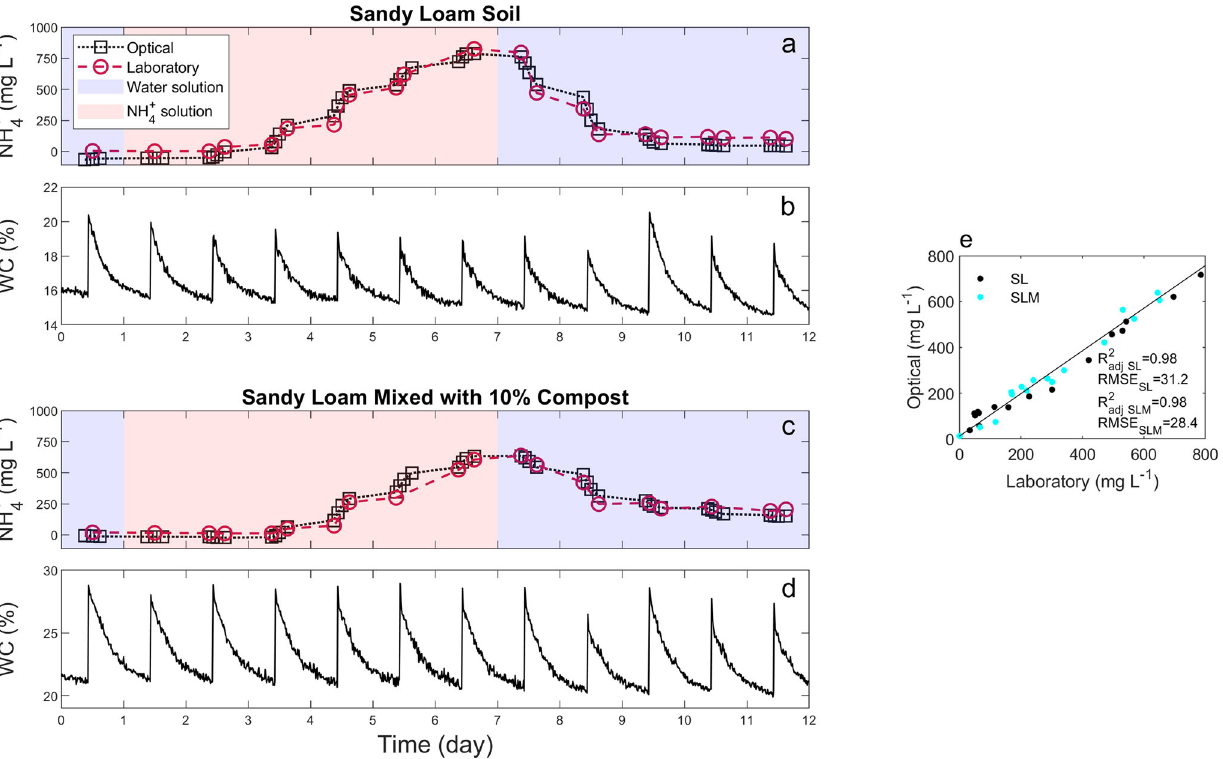
Fig. 4 Ammonium breakthrough curves in soil columns. a , c Breakthrough curves of ammonium in the sandy loam soil (SL) and SL mixed with 10% compost (SLM) columns, respectively, obtained from the optical technique and standard laboratory procedure. b , d Daily WC fl uctuations in both columns. e Regression plot of the optical vs. laboratory